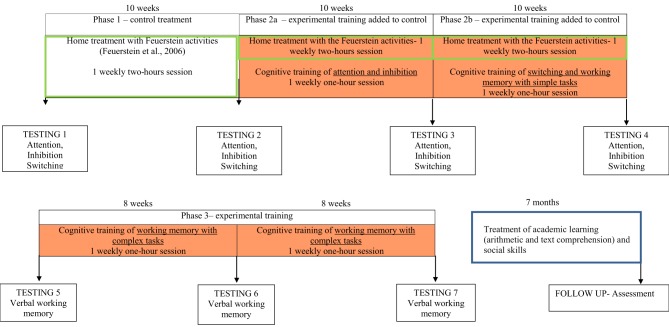
The research design.